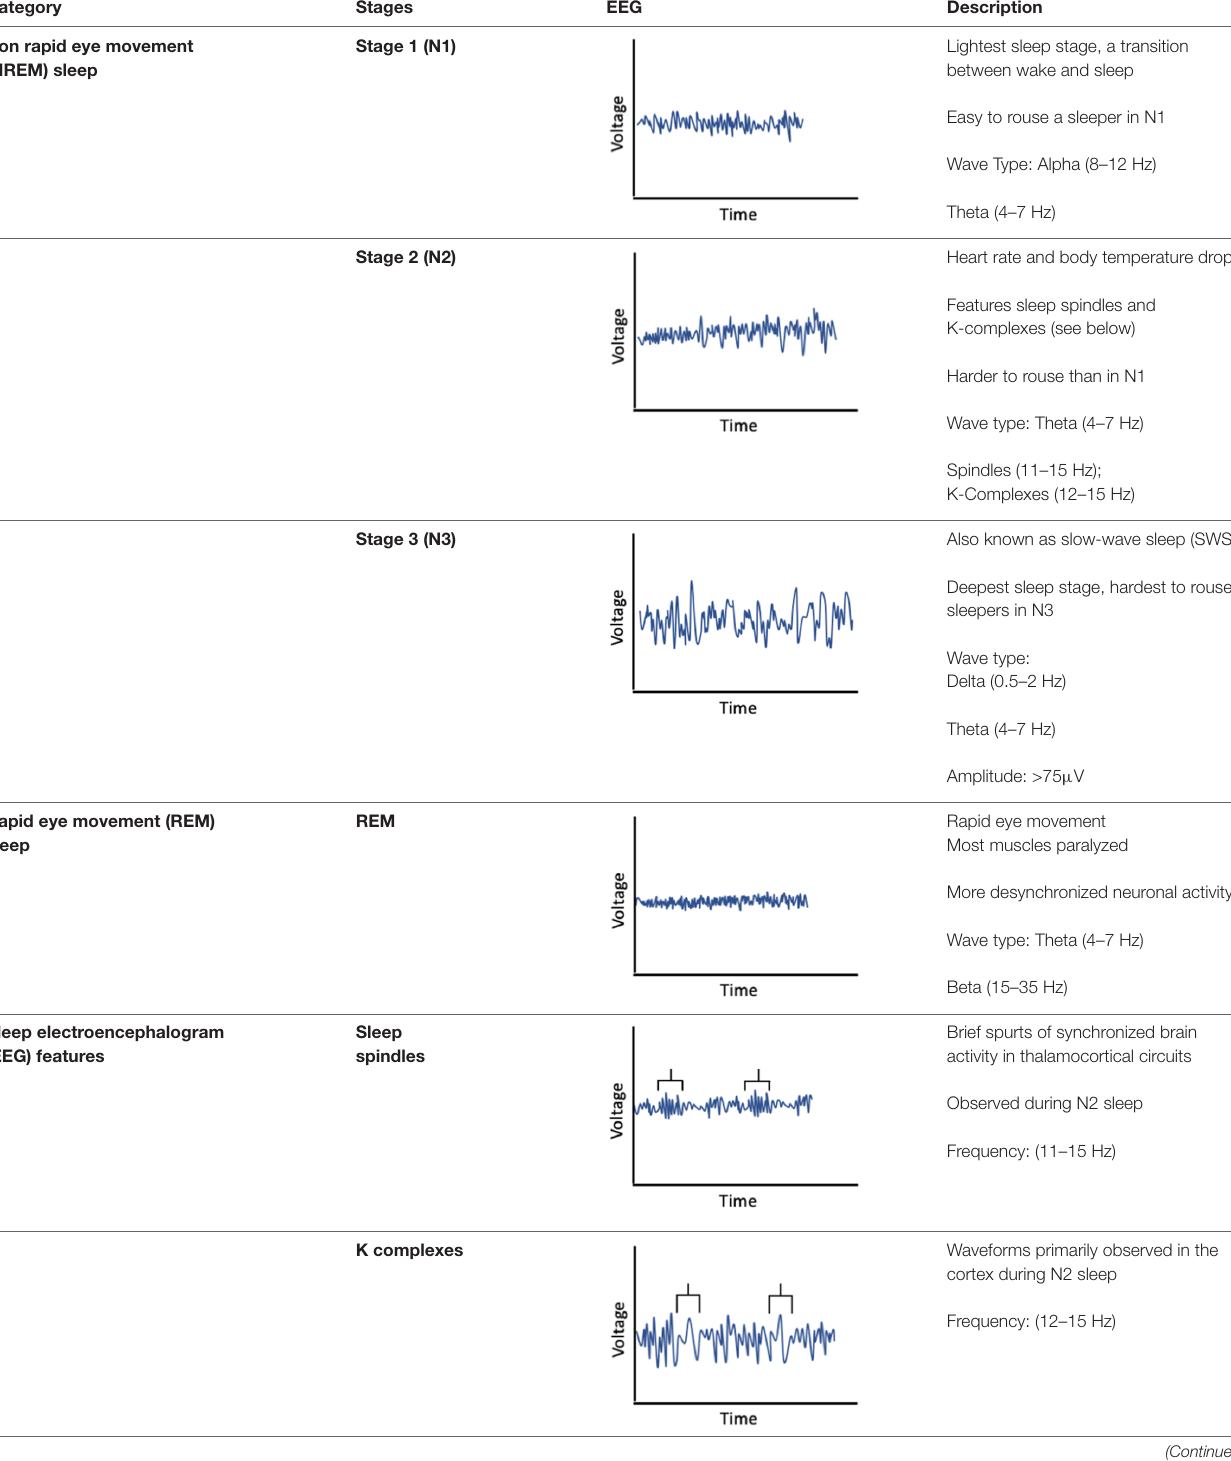
TABLE 1 | Sleep stages and their electroencephalographic